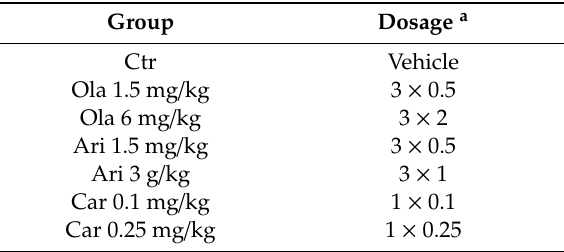
Table 1. The treated / control groups, and